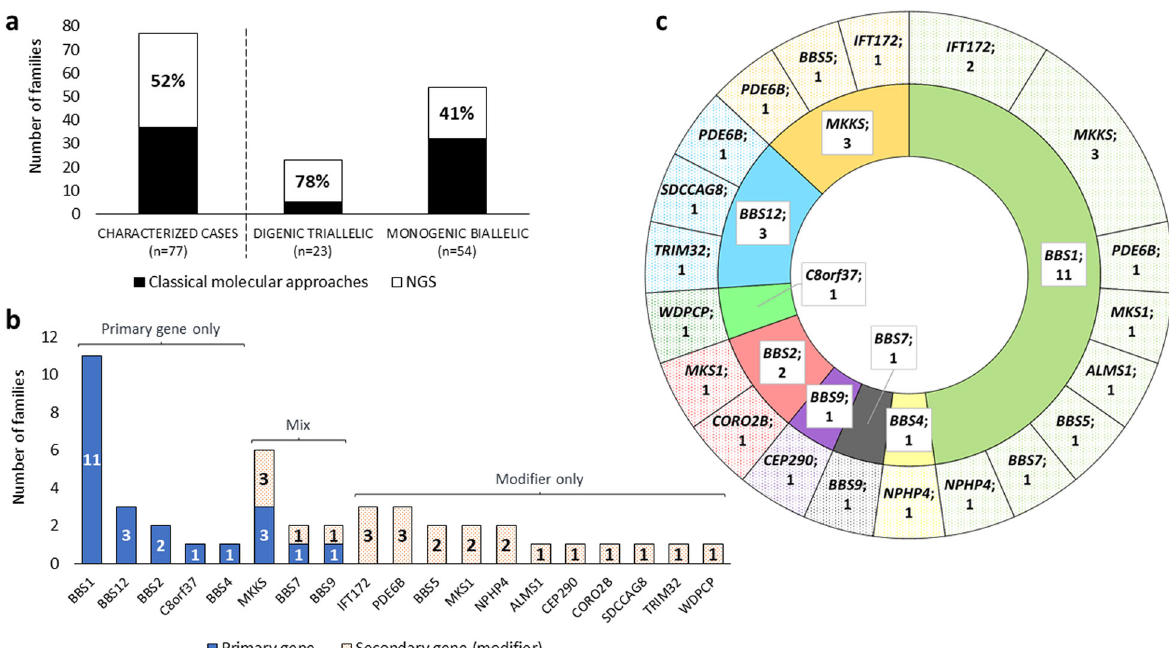
Fig. 2 Mutational load in BBS-related genes. a Distribution of BBS families according to the molecular screening and mutational load. Families are grouped as “ digenic triallelic ” (three mutant alleles in two recessive genes) and “ monogenic biallelic ” (two mutant alleles in a recessive gene). NGS includes customized targeted NGS panel, clinical exome sequencing (CES), and/or whole-exome sequencing (WES). b Mutational load and gene role in the allelic combination. The genes found in the “ digenic triallelic ” families are grouped considering if they are primary (recessive biallelic gene) or secondary (monoallelic modi fi er) genes. c Distribution of the oligogenic cases according to the primary and secondary genes found in the 23 families with suspected triallelic inheritance. Only the genetic outcome of each proband is shown. The inner and outer circles represent the biallelic primary gene and the monoallelic gene (or possible modi fi er) accompanying the biallelic variants,